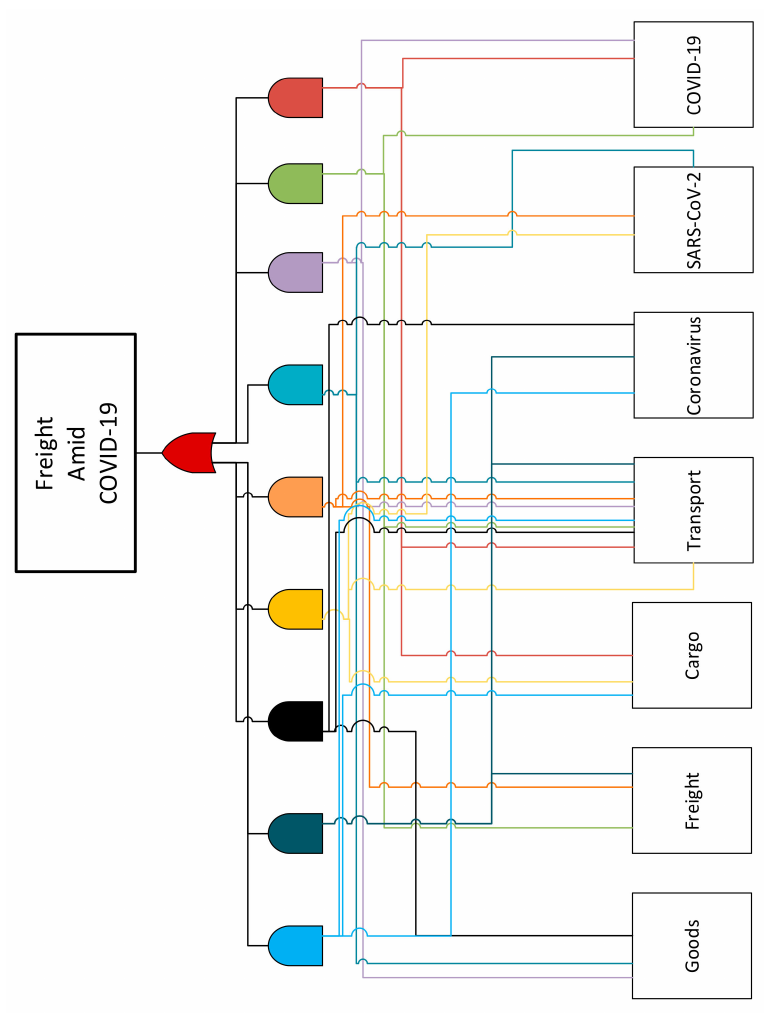
Figure 2. Keywords combination through Boolean logic